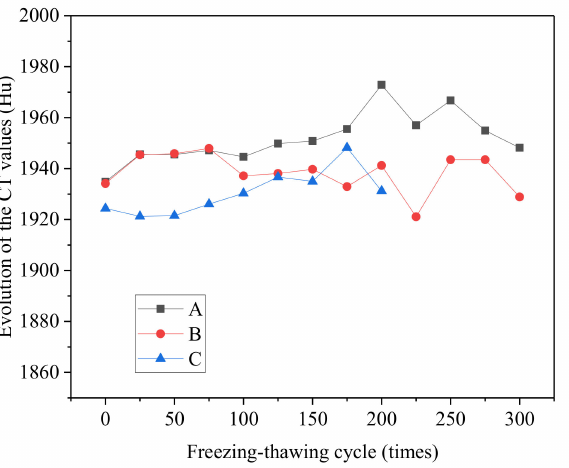
Figure 12. Evolutionary rules of the CT values of solid phases of concrete in different